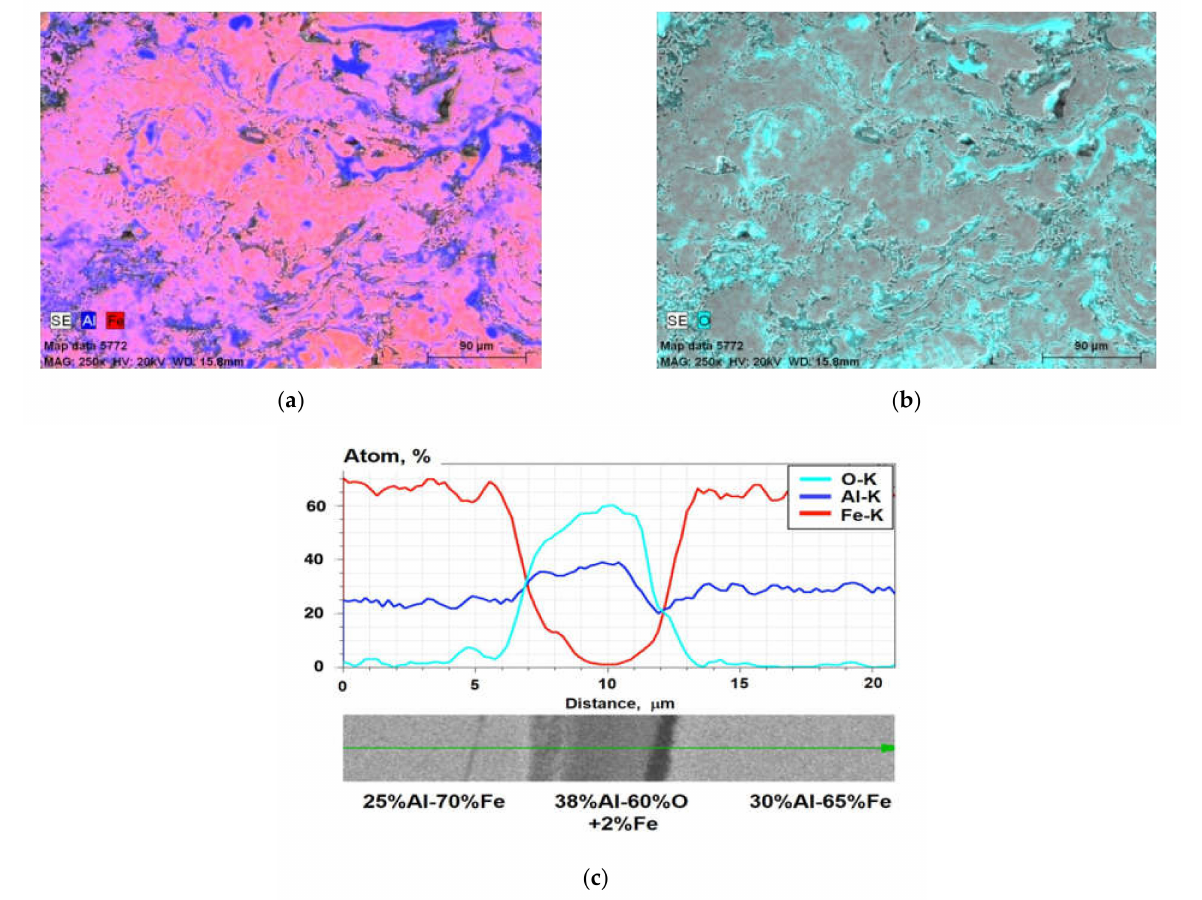
Figure 8. EDX results of elemental distribution in cross-section of the coating annealed in 900 ◦ C: maps of ( a ) Al and Fe and ( b ) O, as well as ( c ) plots of the linear distribution of elements along green